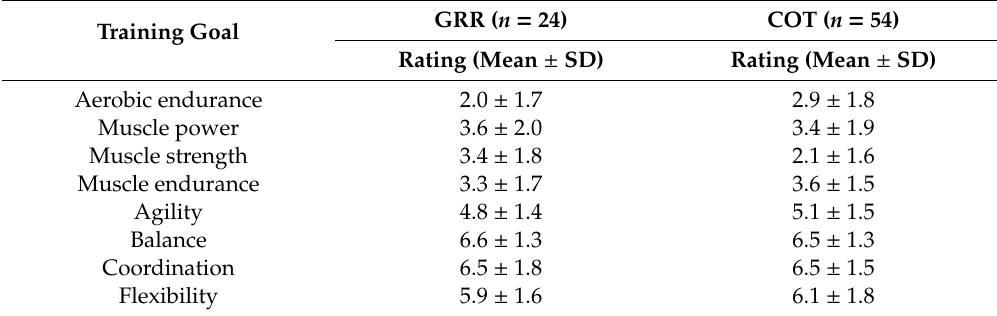
Table 4. Classification of the purpose of the physical training performed by operators of Special Operations Police Units, ranging from 1 (most important) to 10 (least